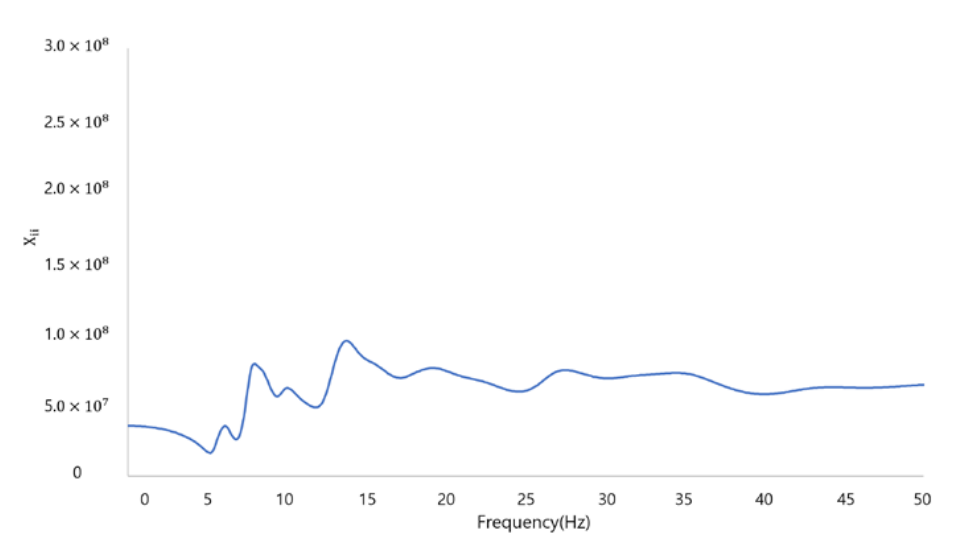
Figure 8. Mechanical impedance by harmonic analysis at equipment location 1 in H1 direction.